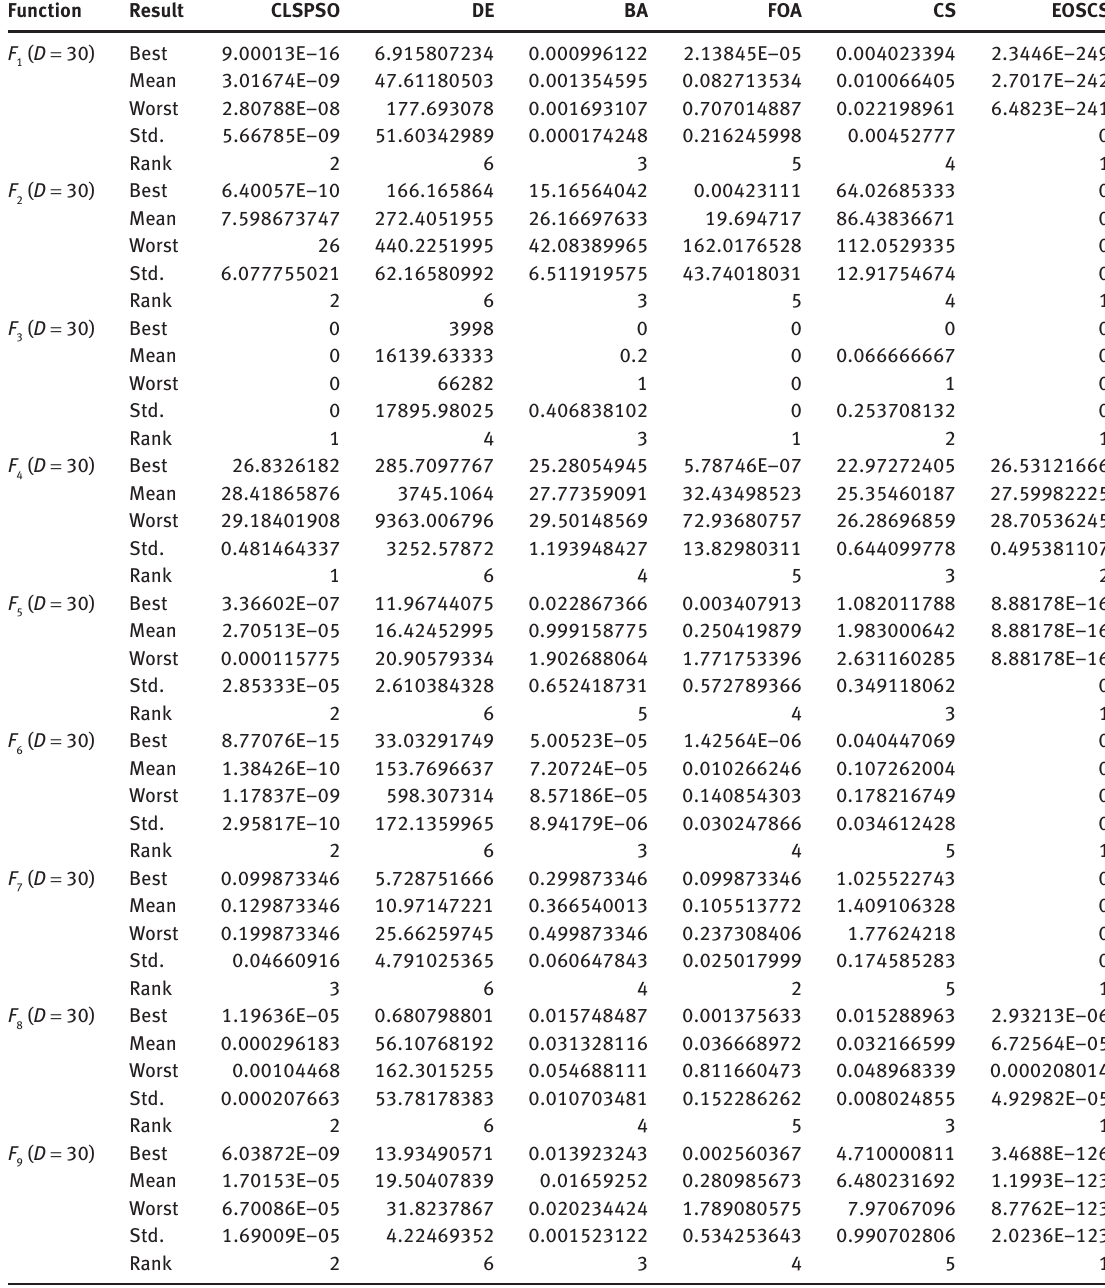
Table 1: Experiment Results of Benchmark Functions for Different Algorithms ( D = 30).